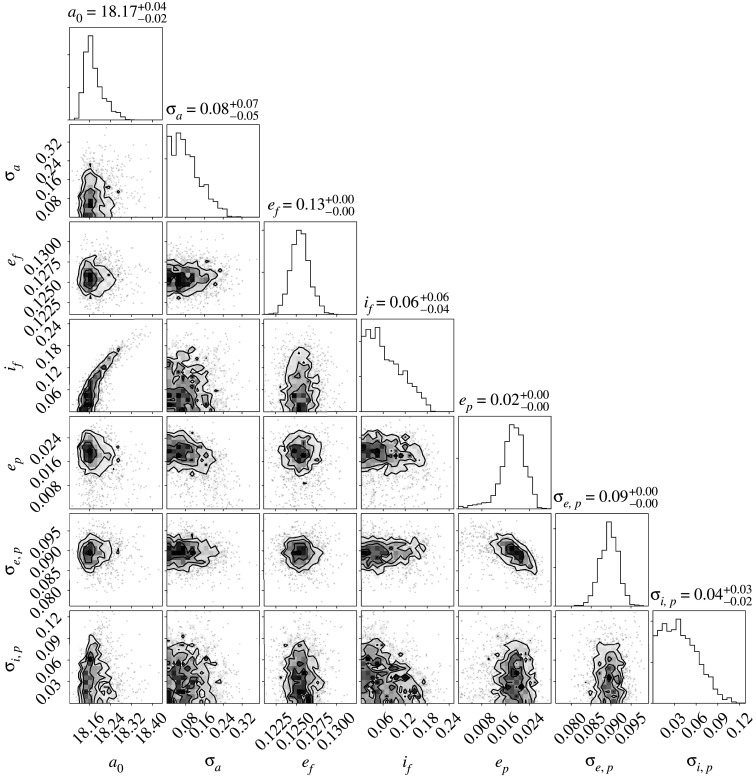
Posterior parameter distributions for the full model of the Fomalhaut ring with a Gaussian range of semi-major axes. Only parameters related to the eccentric disc model are shown here. Each off-diagonal panel shows the two-dimensional distributions, with 1, 2 and 3σ contours in regions of high density, and individual dots in regions of low density. The diagonal panels show the one-dimensional distributions.